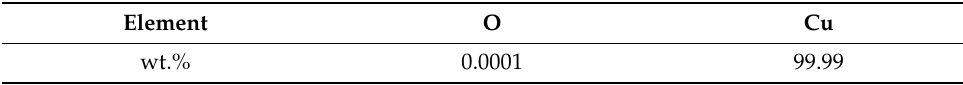
Table 1. Chemical composition of C1020 used in this study.